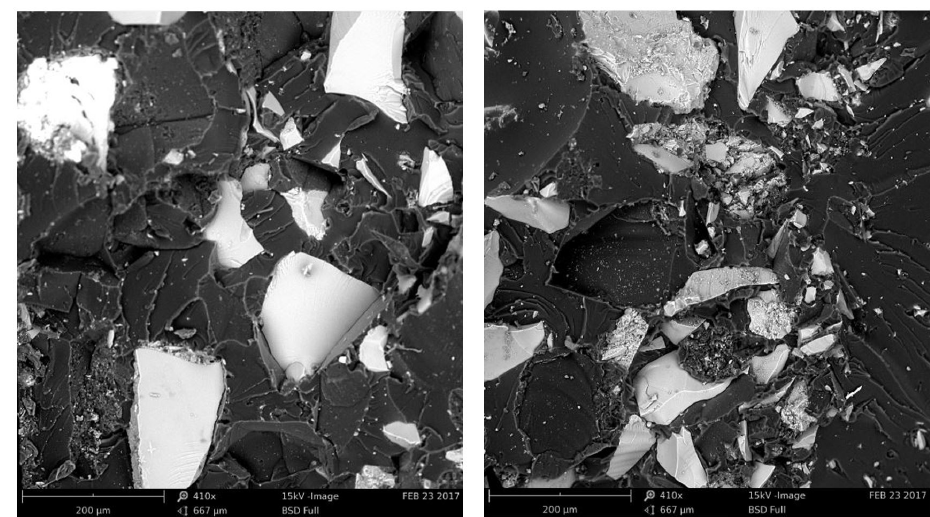
Figure 7. SEM Comparison between W.G.5% (left) and W.G.20% (right).